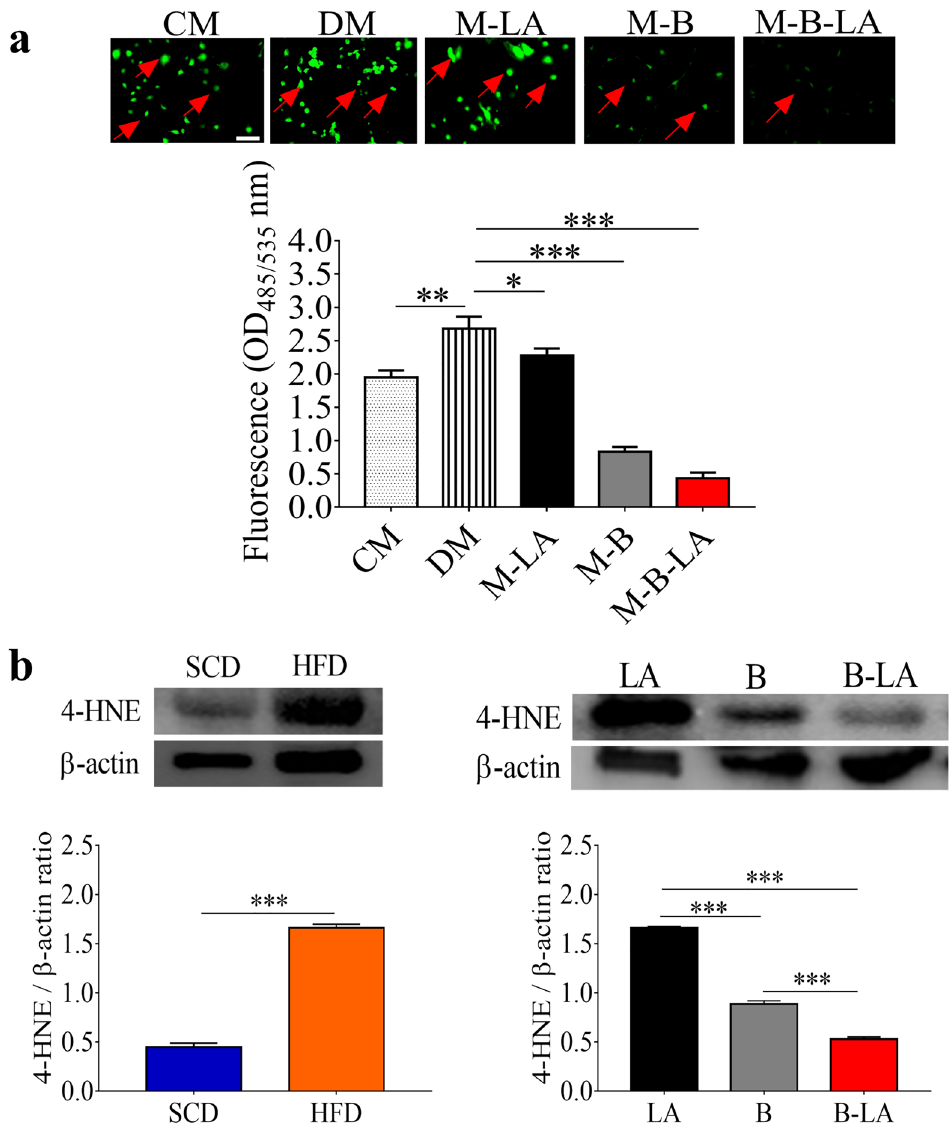
Figure 3. Reduction of the production of ROS and 4-HNE by linoleic acid fermentation of L. mesenteroides EH-1. ( a ) Cells loaded with DCFH-DA were treated with media (CM, DM), linoleic acid (M-LA) or supernatants (M-B or M-B-LA) as described in Fig. 2a. Green fluorescence (arrows) derived from DCFH-DA reaction was quantified by measurement with excitation and emission at 485 and 530 nm. ( b ) ICR mice were fed a SCD or HFD at a 3-day interval for 6 weeks. The levels of 4-HNE and β-actin in abdominal fat mass by western blot analysis were quantified by Image J software. The 4-HNE production in abdominal fats in mice administered with linoleic acid alone (LA), L. mesenteroides EH-1 bacteria alone (B), bacteria plus linoleic acid (B-LA) was examined. The ratio intensities of 4-HNE to β-actin were quantified by Image J software. Full-length western blot images were presented in Fig. S4. Data are the mean ± SD of experiments performed in triplicate. * p < 0.05. ** p < 0.01. *** p < 0.001 (two-tailed t -test by GraphPad Prism 5). Bars = 100